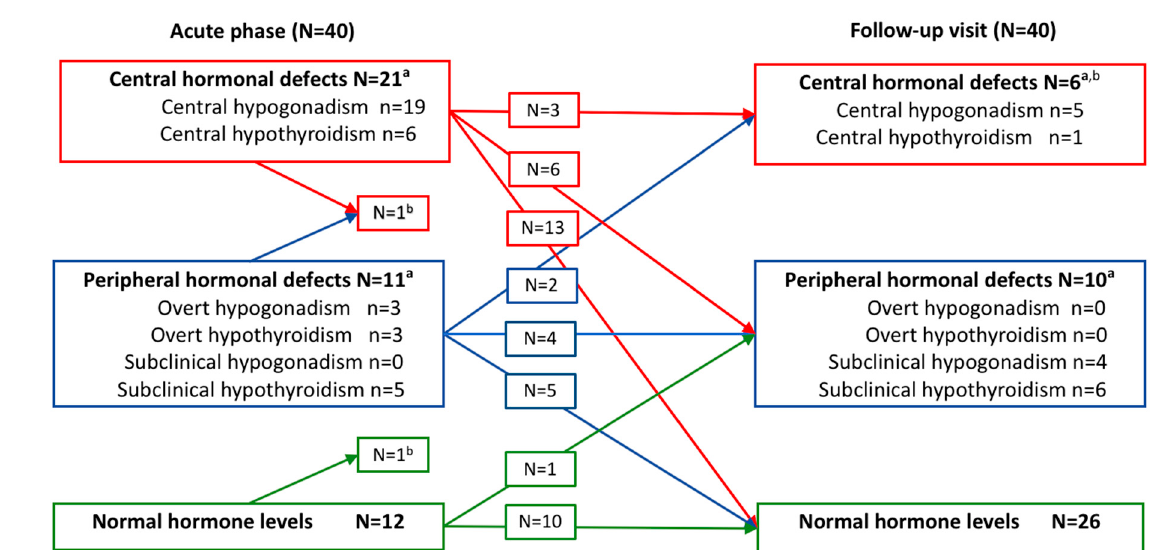
Figure 1. Central and peripheral hormone deficits in 40 patients during acute PUUV infection and at the one-month follow-up visit. a Eight patients had two different hormone defects in the acute phase, and two patients at the follow-up visit, respectively. b Hormone measurements were not available for two patients in the acute phase and two patients at the follow-up visit. N = Number of patients, n = number of hormonal defects.